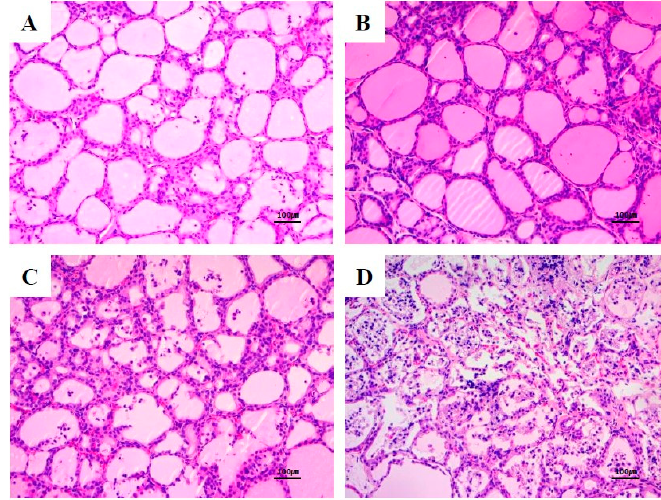
Figure 4. Follicular hyperplasia in the thyroid glands of female Sprague Dawley rats exposed to 0 (vehicle) ( A ), 5 mg/kg/day ( B ), 20 mg/kg/day ( C ), and 100 mg/kg/day ( D ) F-53B by oral gavage for 28 days.